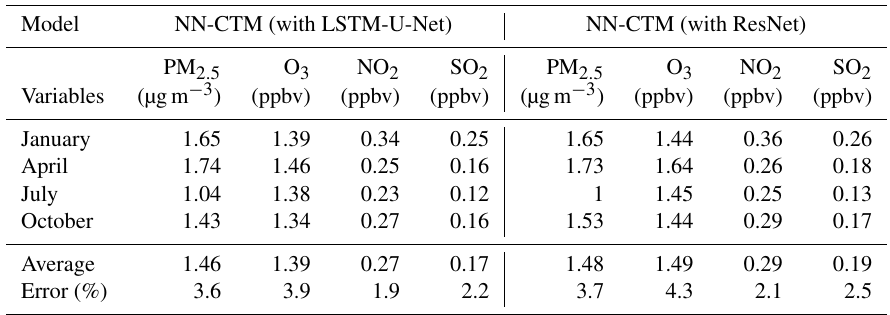
Table 1. Evaluation of the NN-CTM simulation in China (mean absolute error between CTM and NN-CTM). LSTM-U-Net is our proposed method. To compare the model performance, we then select another professional deep neural network method – residual network (ResNet; He et al., 2015a).